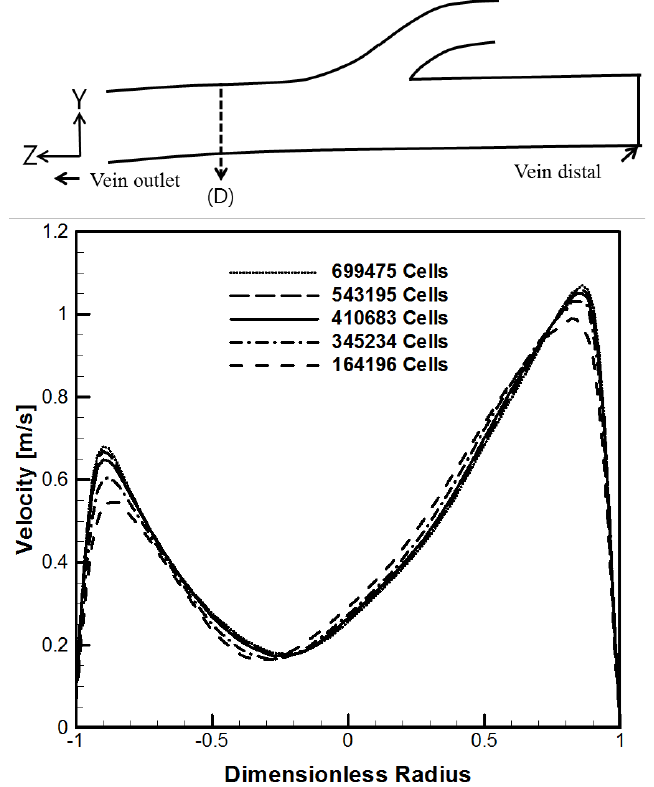
Figure 5. Grid independence test at Line (D).